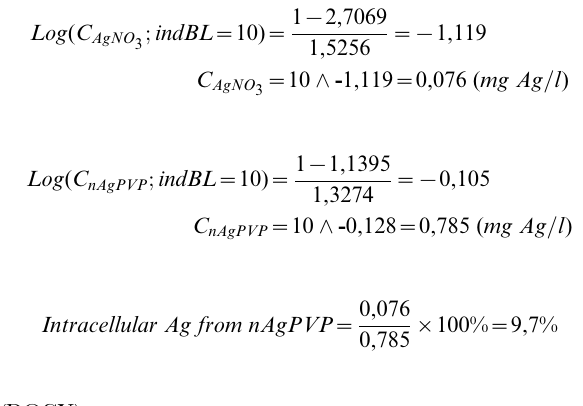
Figure S4 Ultraviolet - visible (UV-Vis) wavelength absorption spectra for silver nanoparticles. UV-Vis spectra for 10 mg/l nAg-Col suspension (A) and 10 mg/l nAg- PVP suspension (B) immediately after dispersion in the test medium (half-strength NaCl-free LB) (solid line) and after 4-h incubation (dashed green line) are shown. The UV-Vis measure- ment could not be conducted for the uncoated nAg NPs due to their quick sedimentation. The plasmon absorption peak at 405 nm is proportional to the concentration of metallic nanosized Ag and the decrease of this peak indicates dissolution of AgNPs. The absence of shift of plasmon absorption peak indicates that AgNPs do not aggregate. Insets in the Figure S4 indicate dissolution of AgNPs measured by atomic absorption spectroscopy (AAS) from the ultracentrifuged (390 000 g for 60 minutes) supernatants of AgNPs. During 4-h incubation, AgNPs dissolved but released Ag ions were complexed by the components of test medium that settled during ultracentrifugation. Figure S5 Growth inhibition of bacterial strains by silver nanoparticles. Growth inhibition of Escherichia coli (A), Bacillus subtilis (B), Staphylococcus aureus (C), Pseudomonas fluorescens (D), Pseudomonas putida (E) and Pseudomonas aeruginosa (F) by uncoated Ag nanoparticles (nAg; triangle), collargol (nAg-Col; rectangle), PVP- coated Ag nanoparticles (nAg-PVP; cross) or AgNO 3 (diamond) after 4-h incubation in half-strength NaCl-free LB medium at 30 u C. The representative figures from three biological replicates are shown. Figure S6 Setup of the dialysis membrane test. Bacterial cells were separated from AgNPs or AgNO 3 by 20 kDa (about 4 nm) dialysis membrane (Slide-A-Lyzer MINI Dialysis Device, 20K MWCO, Thermo Scientific). 400 m l of bacterial suspension was pipetted into the wells, polypropylene cups with the dialysis membrane on the bottom were inserted into the wells and 400 m l of AgNPs, AgNO 3 or DI water (control) was pipetted into the cups. During the optical density measurements the cups were removed. Figure S7 UV-visible absorption spectra of nAg-Col suspensions (10 mg Ag/l) with or without bacteria. UV- Vis spectra of AgNPs in half-strength NaCl-free LB medium without bacterial cells (dashed red line) or after exposure of nAg- Col to bacterial cells (solid line). No separation of particles and/or bacterial cells was done before the measurement. The experiment is a control for Figure 7 to exclude the interference of bacterial cells with the measurements of UV-Vis absorption spectra of nAg-